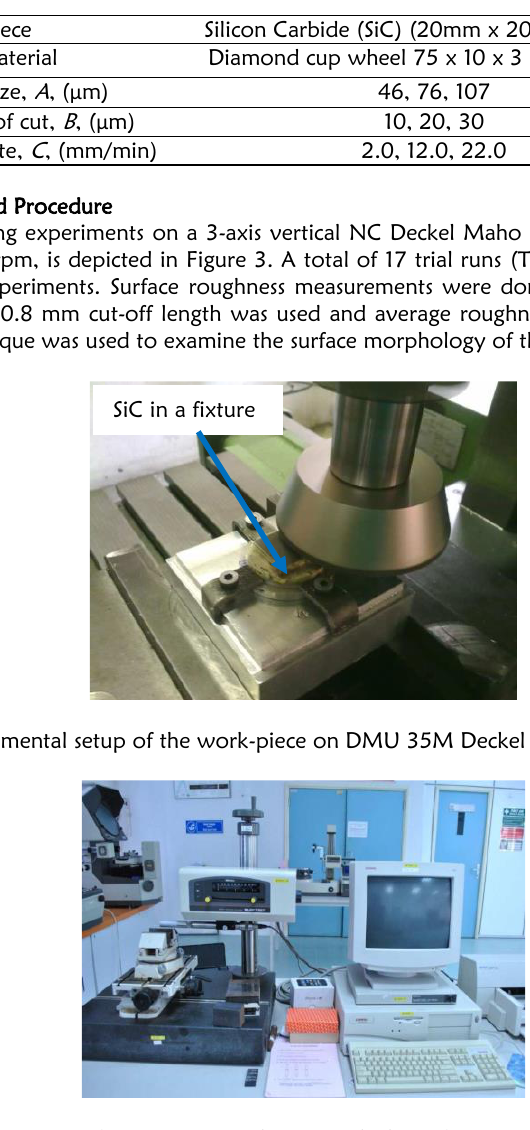
Figure 4: Mitutoyo Surftest SV-500 machine on which, surface roughness was